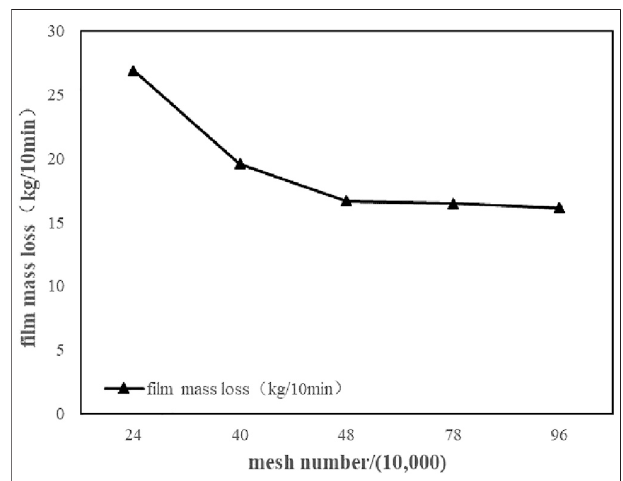
FIGURE 5 | Film losses with different mesh